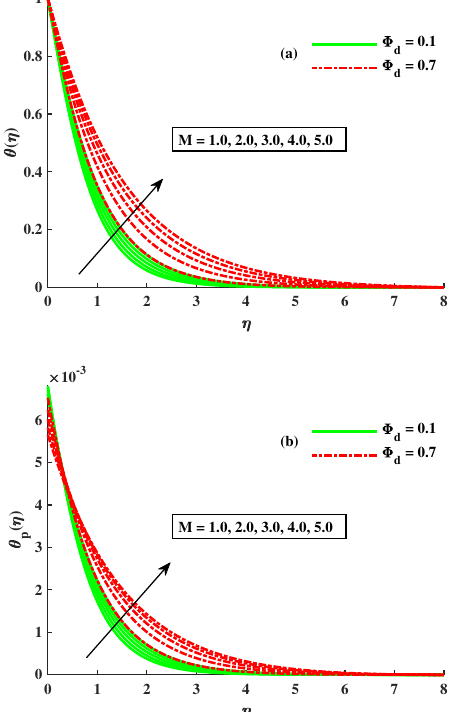
Figure 9. Influence of φ d & M on ( a ) θ ( η ) & ( b ) θ p ( η )